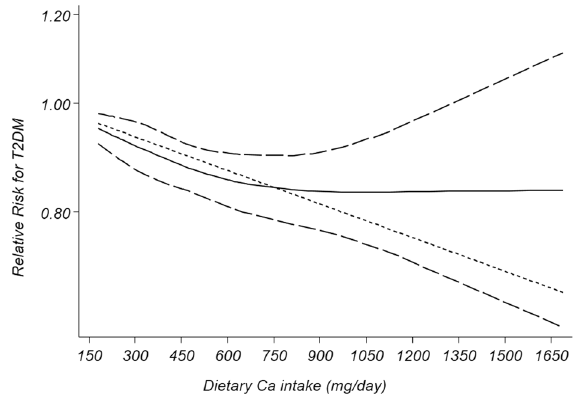
Figure 4. Non-linear dose–response association between dietary Ca intake levels and T2DM in prospective cohort studies with representative adult populations.—-—, Linear model; ____, spline model.